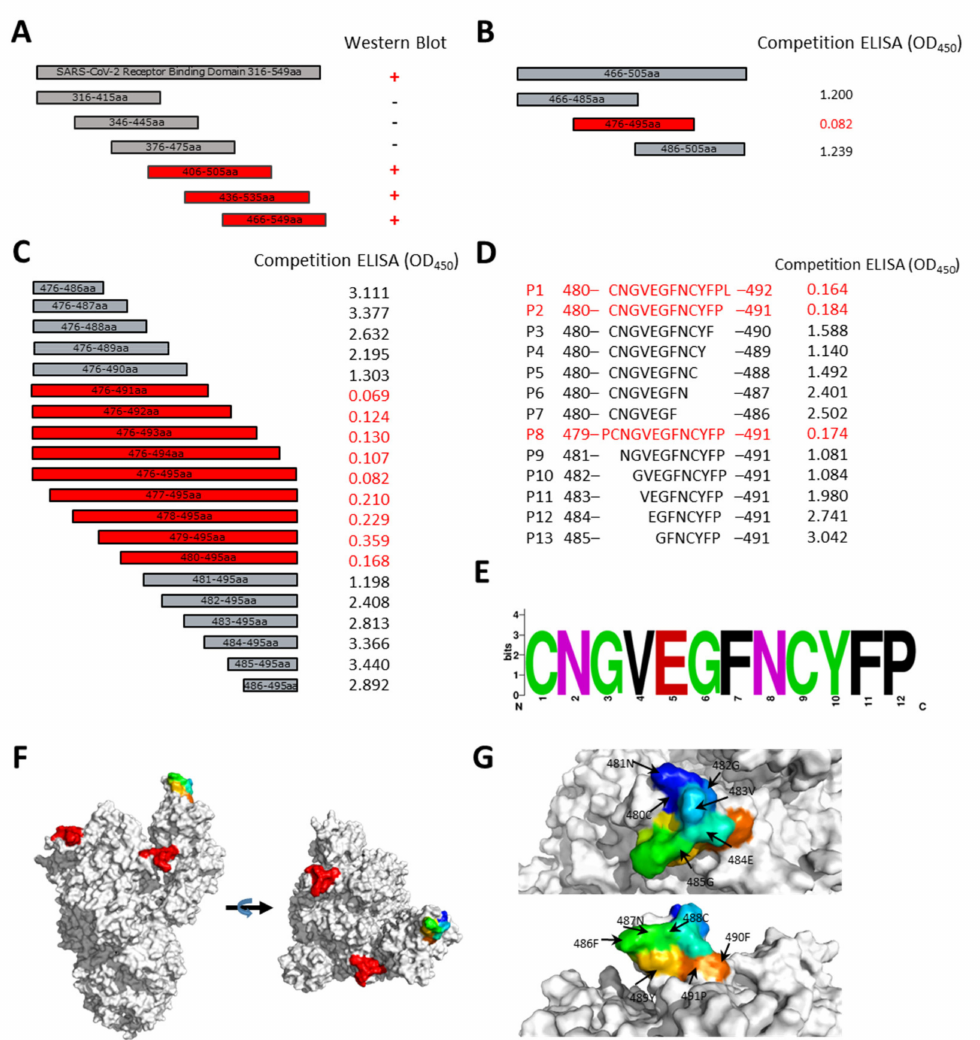
Figure 4. Epitope identification of 9E1. ( A ) Western blot result of 9E1 with overlapping RBD fragments. Color in red (+) means positive reactivity, color in gray (-) means negative reactivity. ( B ) Competition ELISA of 9E1 with three truncated peptides. ( C ) Competition ELISA of 9E1 with a panel of synthesized peptides. ( D ) Reconfirmation of 9E1 recognizing epitope with competition ELISA. 9E1 was mixed with peptides, and then the mixture was tested in indirect ELISA. The peptide which can block the binding of 9E1 to RBD was showed in red (low OD value). ( E ) Conservation analysis of 9E1 recognized epitope ( F ). The epitope of 9E1 was illustrated on the 3D structure of S Trimer in different angles (labeled with red and rainbow colors). ( G ) The detail of epitope recognized by 9E1 is displayed. Amino acids were labeled in variable colors. Images were edited with PyMOL and the PDB accession number of S protein is